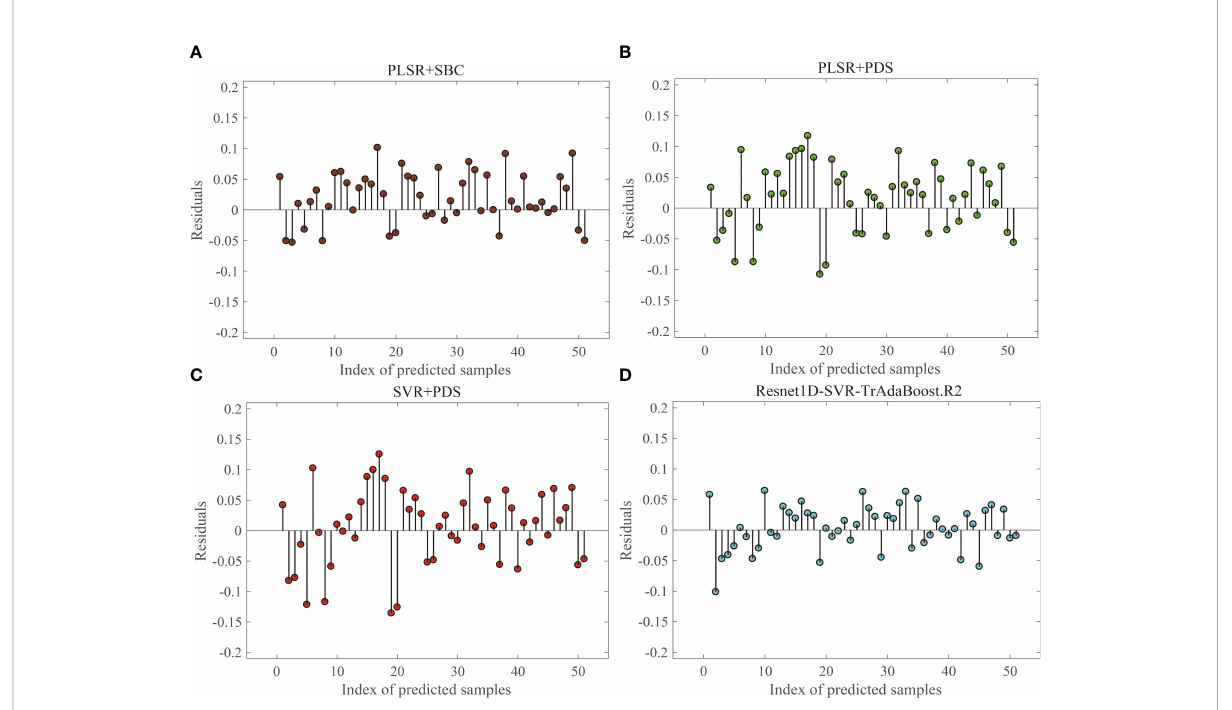
FIGURE 9 Residual analysis for target domain with 70% moisture content group: PLSR+SBC (A) , PLSR+PDS (B) , SVR+PDS (C) , Resnet1D-SVR-TrAdaBoost.R2 (D)